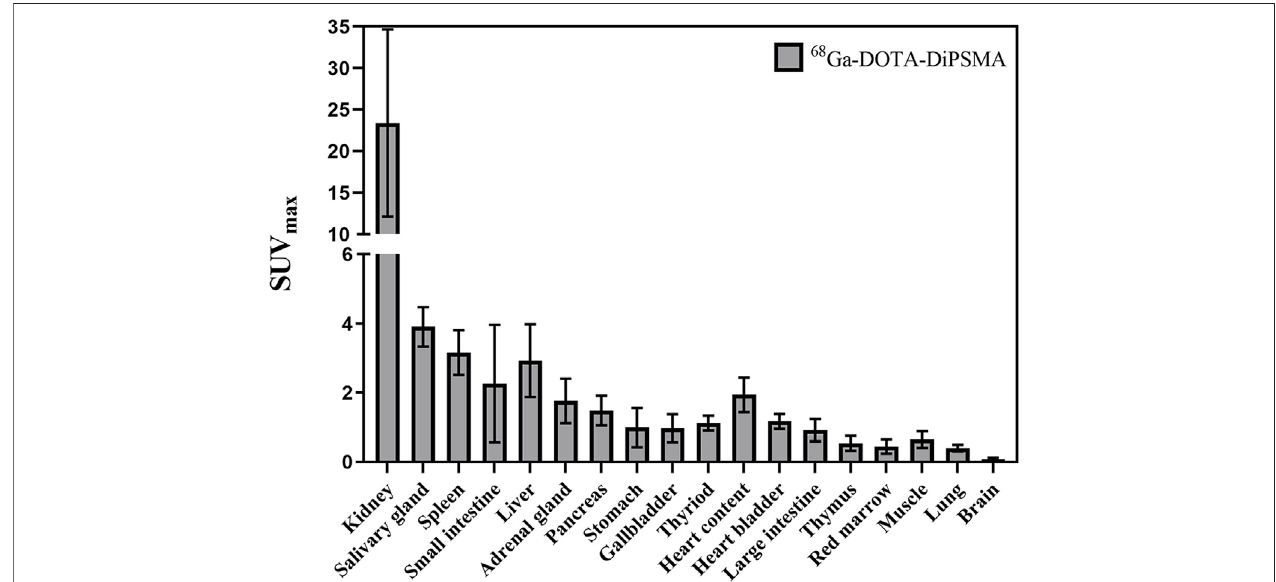
FIGURE 5 | Normal organs ’ SUV max (average in 10 patients) of 68 Ga-DOTA-DiPSMA.